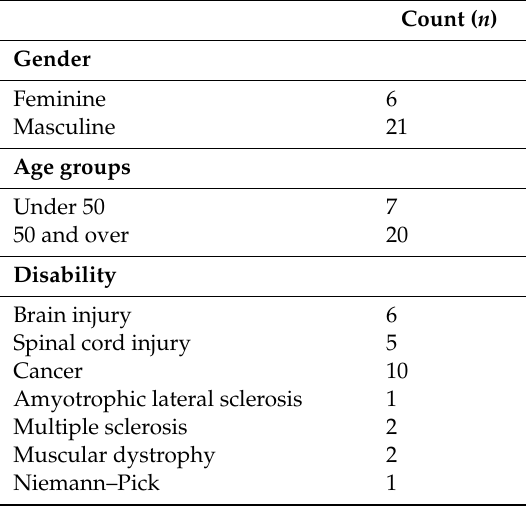
Table 1. Participants’ data and types of